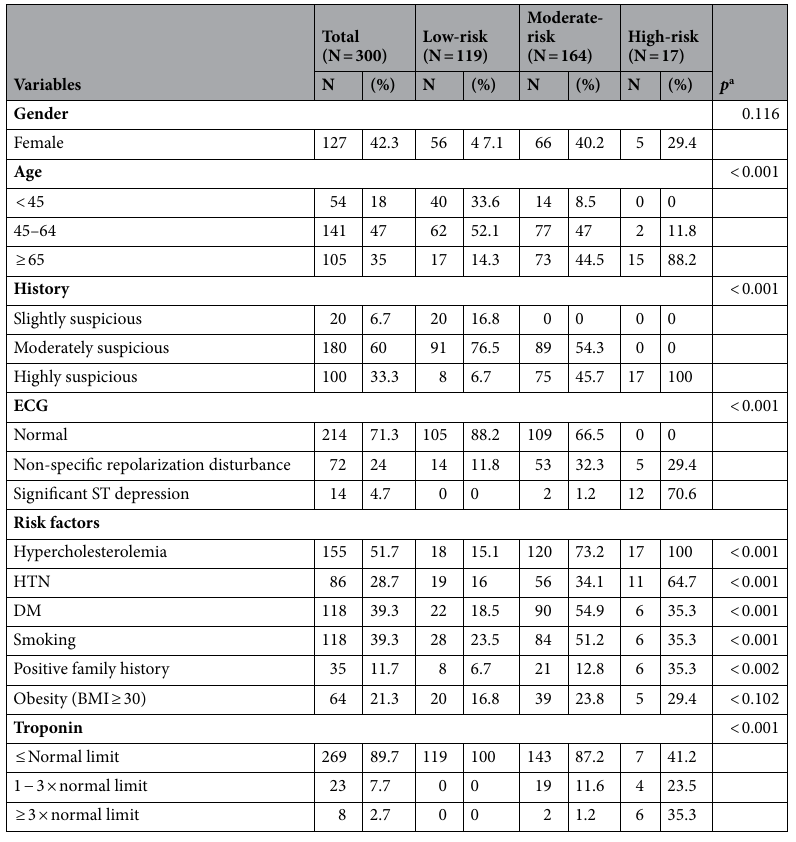
Table 1. Baseline patient characteristics by HEART risk score. ECG Electrocardiogram, HTN Hypertension, DM Diabetes mellitus, BMI Body mass index. a Chi-square